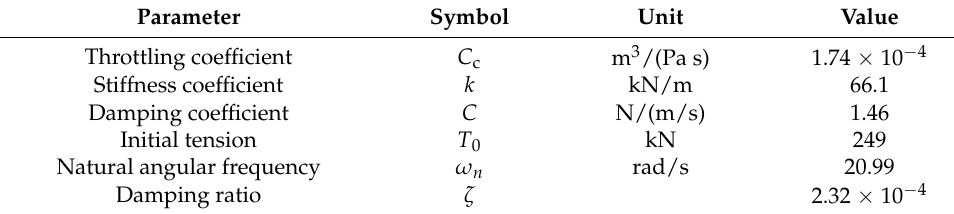
Table 2. Calculated system